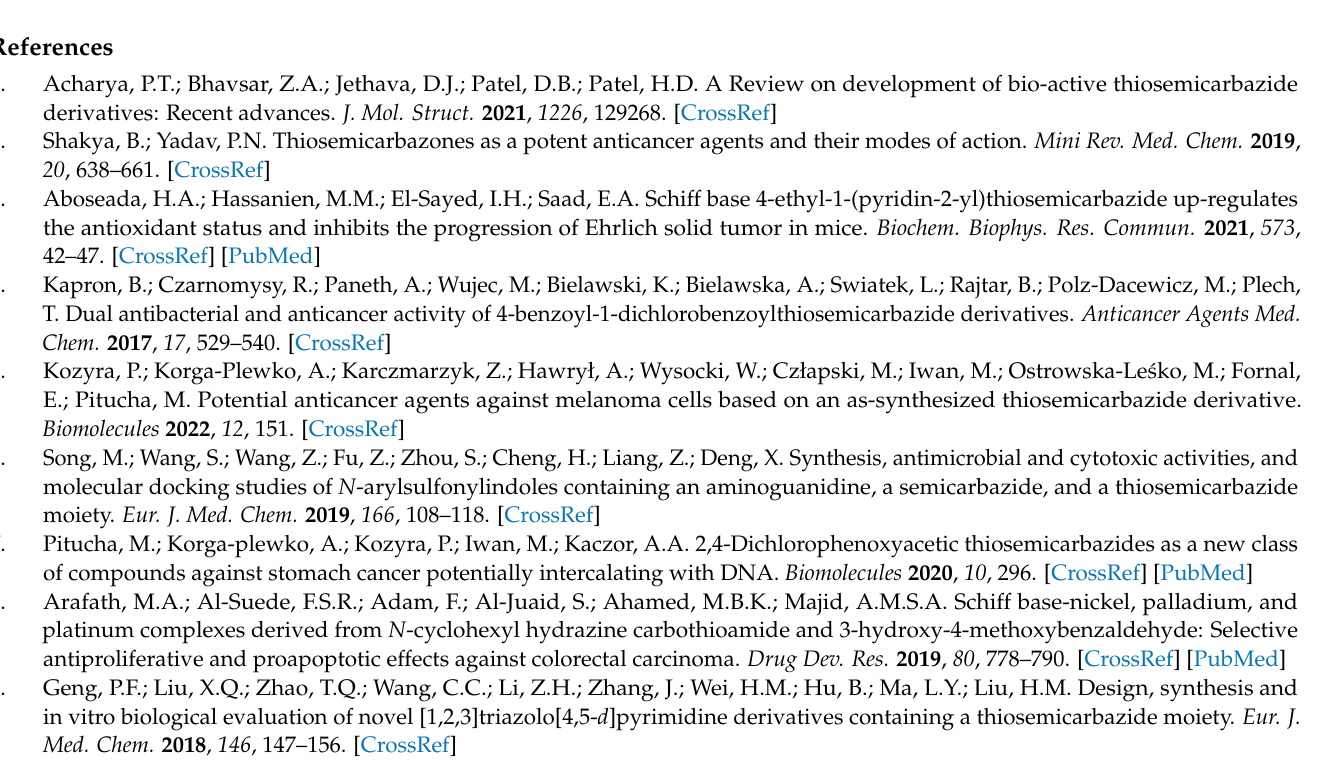
Figure S2: Molecular graphs of various dimers observed in compound 2 showing important in- termolecular interactions at their bond critical; Figure S3: 1 H NMR spectrum of compound 1 in DMSO- d 6 ; Figure S4: 13 C NMR spectrum of compound 1 in DMSO- d 6 ; Figure S5: 1 H NMR spectrum of compound 2 in DMSO- d 6 ; and Figure S6: 13 C NMR spectrum of compound 2 in DMSO- d 6 , the experimental details for determination of in vitro urease inhibitory and antiproliferative